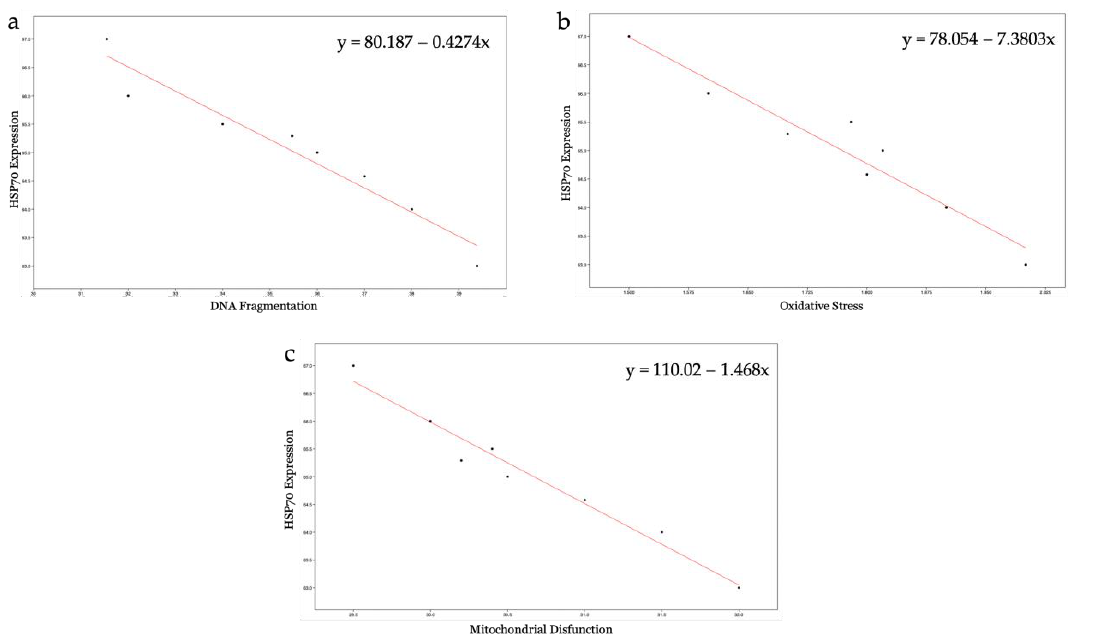
Figure 9. Mean percentage of spermatozoa that expressed HSP70 after the exposure (30 min) to 50 and 100 nm PS-NPs at increasing concentrations. Approximately 400 spermatozoa were counted in five different fields for each sample. In addition, two replicates were performed, in a total of 8 sam- ples and 3200 spermatozoa analyzed. Strong statistically differences (** p < 0.01) have been found between samples exposed to all concentration of 50 nm PS-NPs compared to the control group.